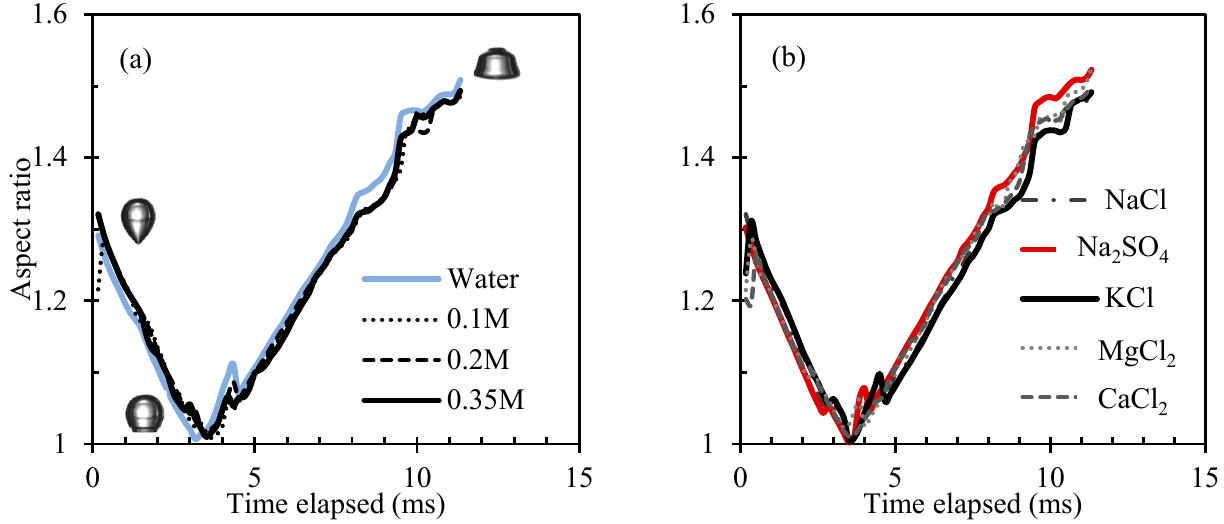
Figure 4 . Aspect ratio: ( a ) in water and NaCl solutions (bubble images taken in RO water); ( b ) in 0.35 M salt solutions.